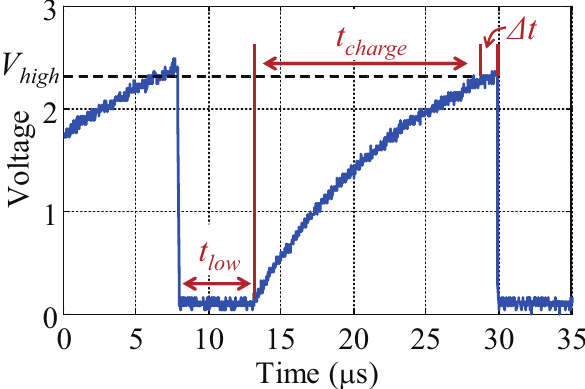
Figure 9. The time for each bit